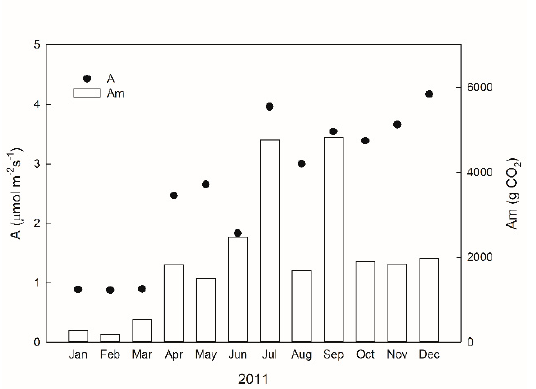
Figure 5. The monthly leaf assimilation rate (A) and monthly CO 2 assimilation (Am) of Zelkova serrata (Thunb.) Makino.